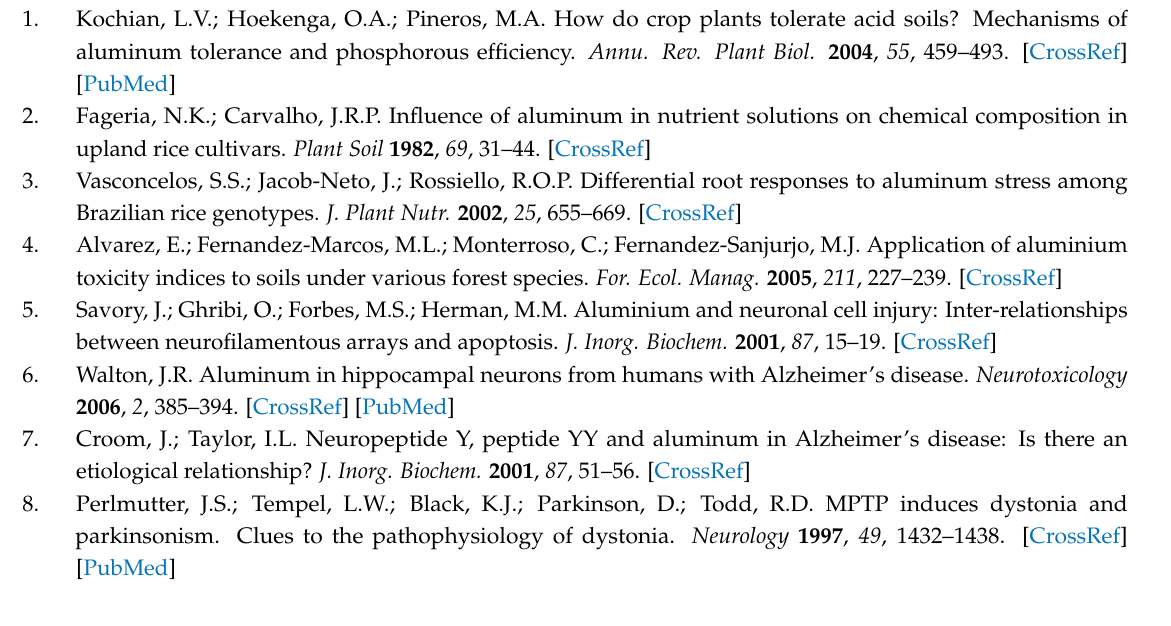
Figure S1: 1 H NMR (DMSO- d 6 ) spectra for probe L , Figure S2: 13 C NMR (DMSO- d 6 ) spectra for probe L , Figure S3: High-resolution mass spectrometry data for probe L , Figure S4: Fluorescence intensity at 536 nm ( λ ex. = 320 nm) for probe L (40 µ M) in the presence of 5 equiv. of various cations in DMSO-H2O (1:9 v / v ), Figure S5: Job plot of probe L and Al 3+ , Figure S6: ESI mass spectra [(probe L + Al 3+ + DMSO + ClO4 − ) + 2Na + ], Figure S7: Hill plot, Figure S8: Fluorescence emission intensity for probe L (40 λ M) in the presence and absence of Al 3+ (5 equiv) at different pH, Figure S9: Color changes by UV light for probe L with the addition of 5 equiv. of Al 3+ at different pH